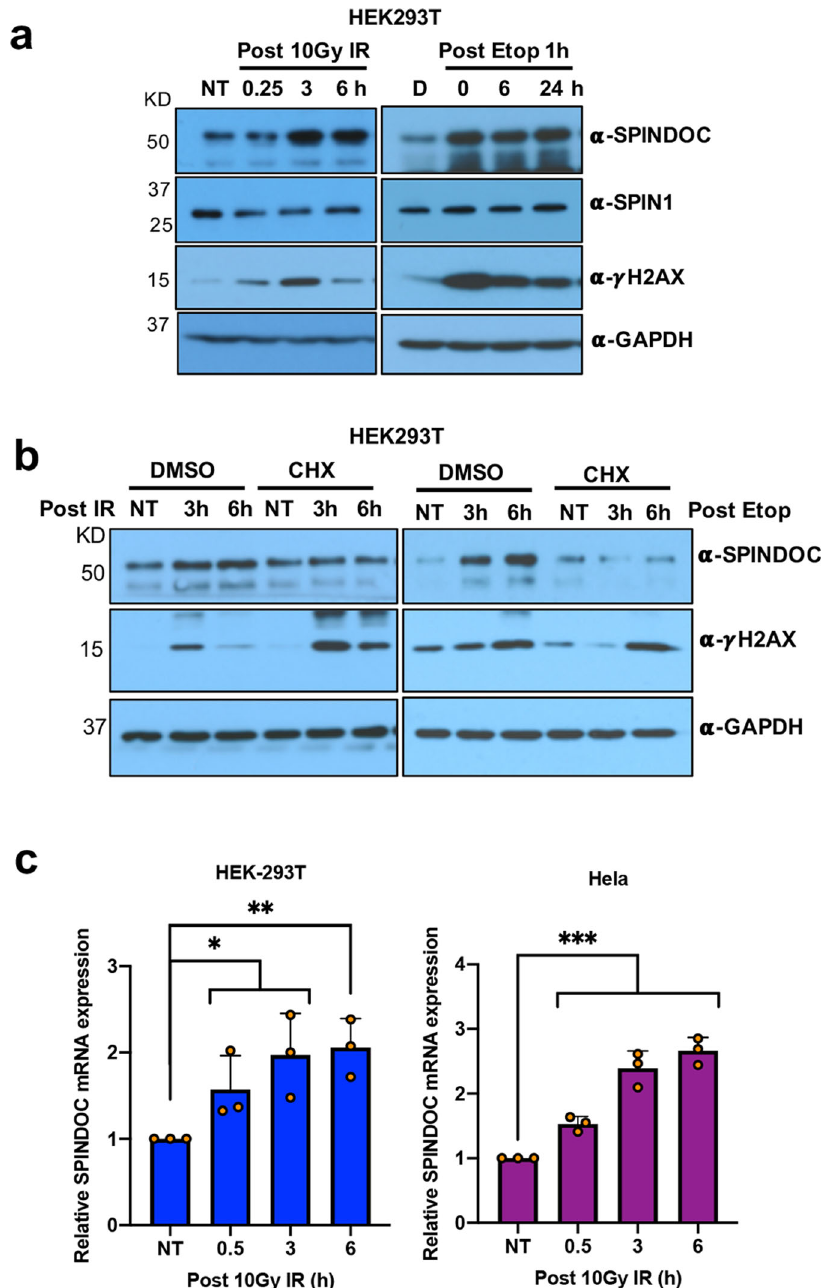
Fig. 4 DSBs induce SPINDOC expression at both the mRNA and protein levels. a HEK293T cells were treated with 10 Gy IR and 40 μ M Etoposide for one hour before media replacement, and samples were taken at the indicated timepoints for Western blot analysis. Nontreated (NT) cells serve as a control, and DMSO treatment (D) as a solvent control. The results were shown as representative blots from three times independent experiments. b HEK293T cells were treated with DMSO or 10 μ M CHX and then immediately treated with 10-Gy IR (left panels) or 40 μ M Etoposide for an hour before replacing media (right panels) and incubated for either 3- or 6 h. Western blot analysis was then performed using the indicated antibodies. The results were repeated three times independent experiments, shown as representative blots. c HEK293T and Hela cells were treated with 10-Gy IR and cultured further for 0.5, 3, and 6 h. Total RNAs were extracted for RT-qPCR analysis of SPINDOC mRNA levels. Graphs represent mean ± SD, n = 3 biologically independent samples. Statistical analysis was performed using one-tailed Student ’ s t -test with HEK293T IR treatment compared with NT, 0.5 h, P = 0.0320, 3 h, P = 0.0126, 6 h, P = 0.0027, *** P < levels when the cells were either Etoposide- or IR-treated. Fur- thermore, we performed reciprocal IPs for GFP-SPINDOC and PARP1 upon Etoposide treatment and the result showed that DNA damage dramatically increased the interaction of these two proteins (Supplementary Fig. 4b, c). This indicates that the SPINDOC/PARP1 interaction is promoted during DDR.